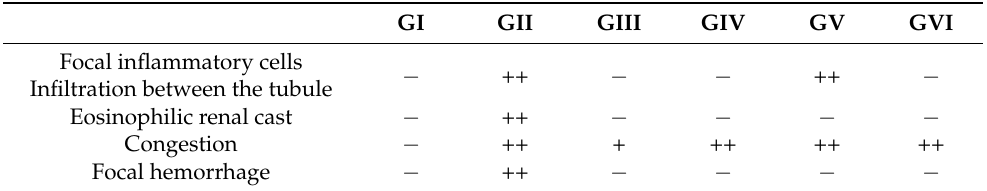
Table 6. The severity of histopathological alteration in rat kidney’s underlying structure of different experimental groups treated by A. hierochuntica